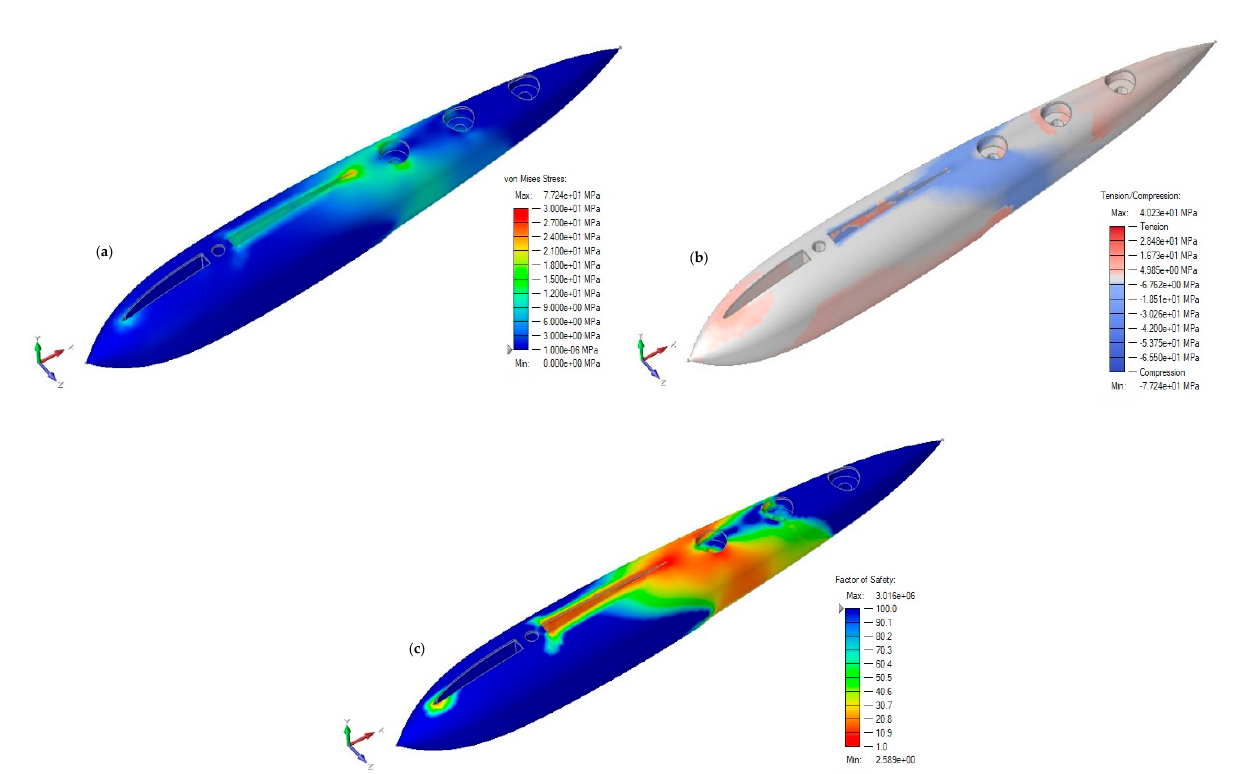
Figure 13. ( a ) von Mises stress, ( b ) tension-compression, ( c ) safety factor (wrt. YS) analyses on Working (0 ◦ , s) load case.